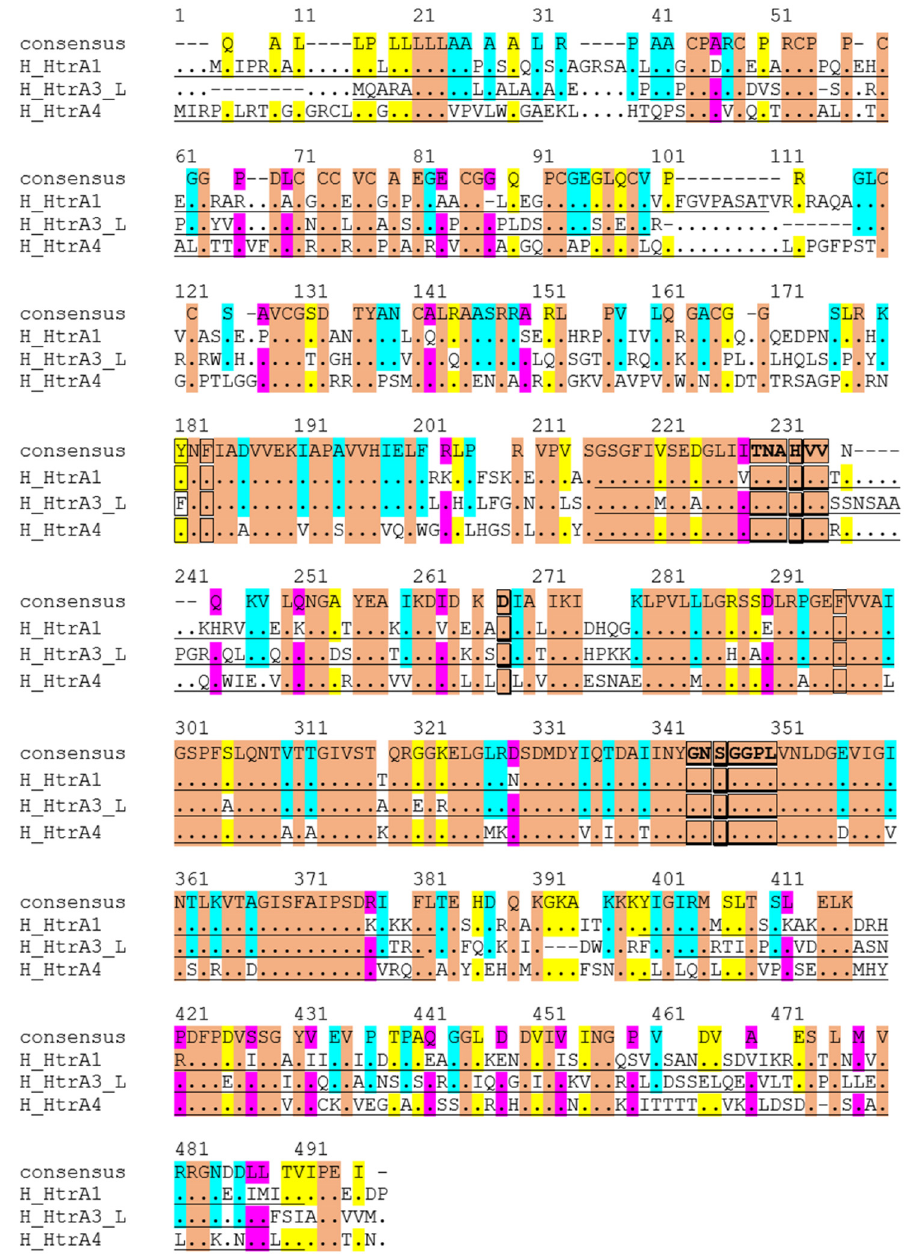
Figure 3. Alignment of amino acid sequences of human HtrA1, 3 and 4. Conserved amino acids are coloured: Orange, identical across all three HtrAs. Blue, similar between HtrA1 and HtrA3. Yellow, matching between HtrA1 and HtrA4. Pink, alike between HtrA3 and HtrA4.